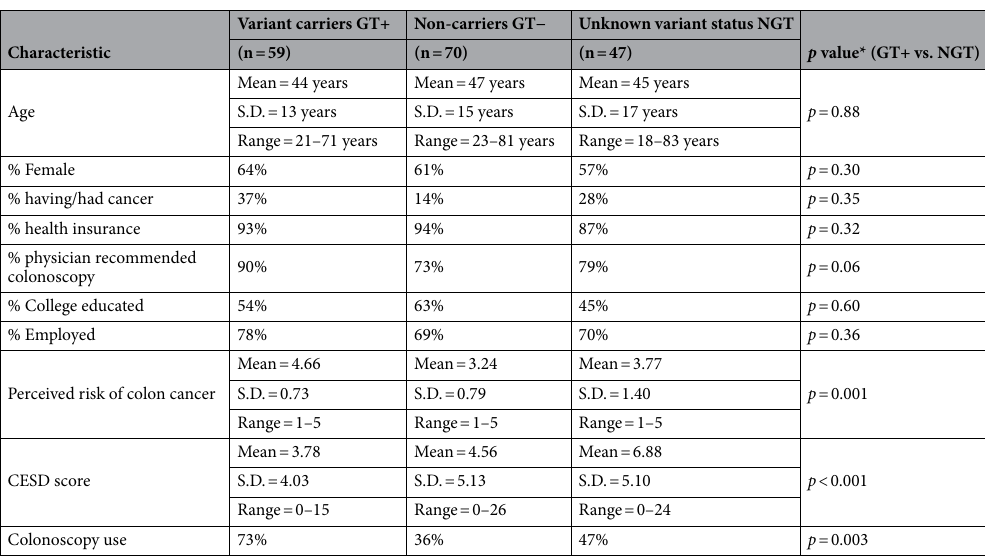
Table 1. Demographic characteristics, physician recommended colonoscopy, perceived risk, wellbeing, and colonoscopy screening by variant status (n =